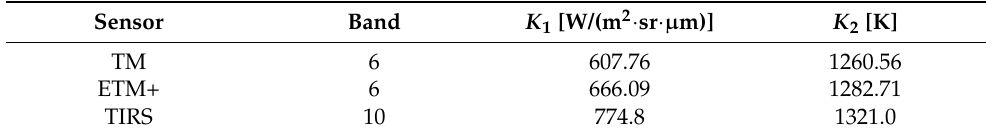
Table 3. Landsat thermal band conversion